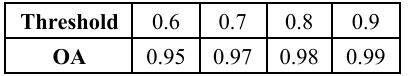
Table 5. Overall accuracy of the resulting